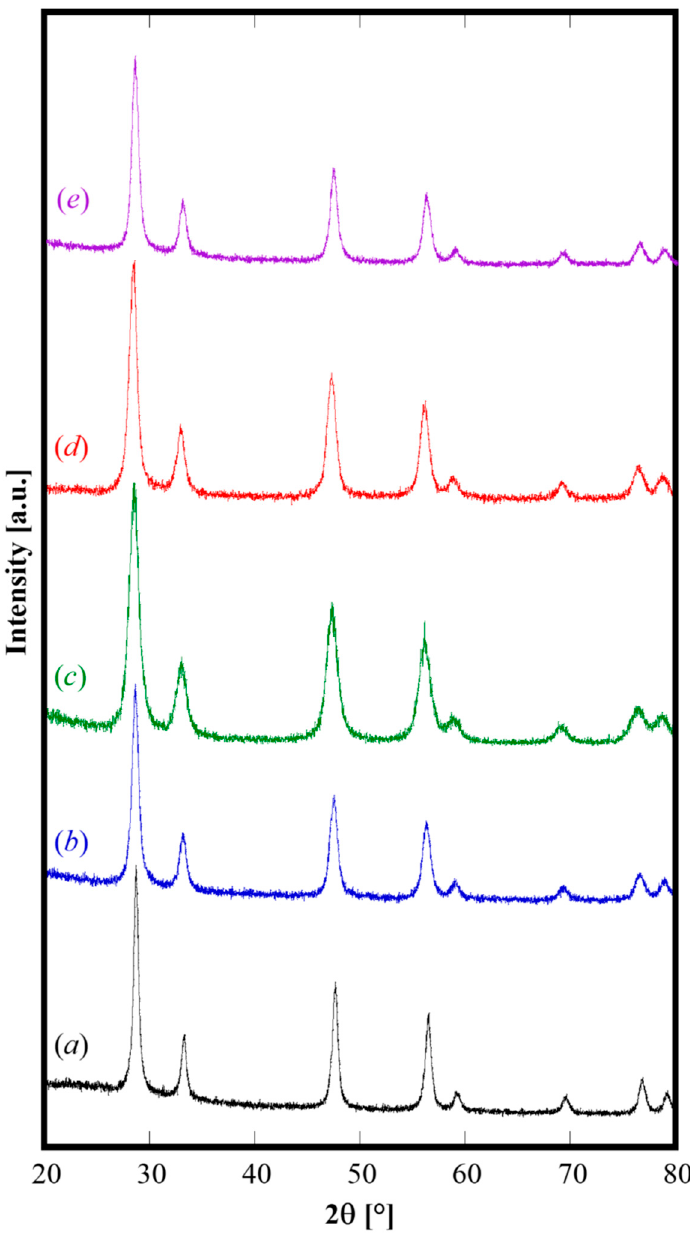
Figure 3. XRD patterns of calcined samples C ( a ), GDC20 ( b ), SDC20 ( c ), GPrDC20 ( d ), and SCaDC20 ( e ). Table 2. Lattice parameter and crystallite size of calcined samples.